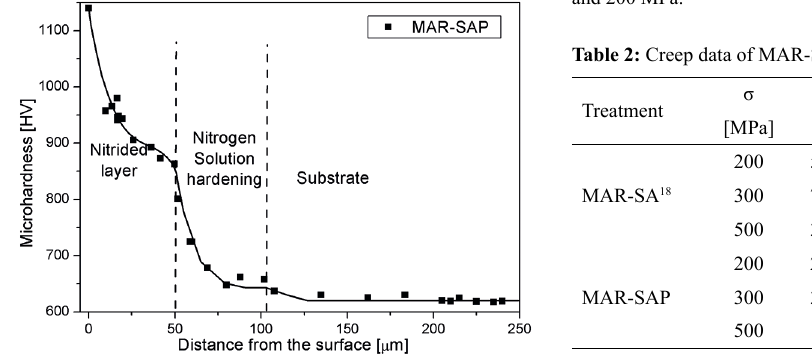
Figure 3: Microhardness profile of MAR-SAP.